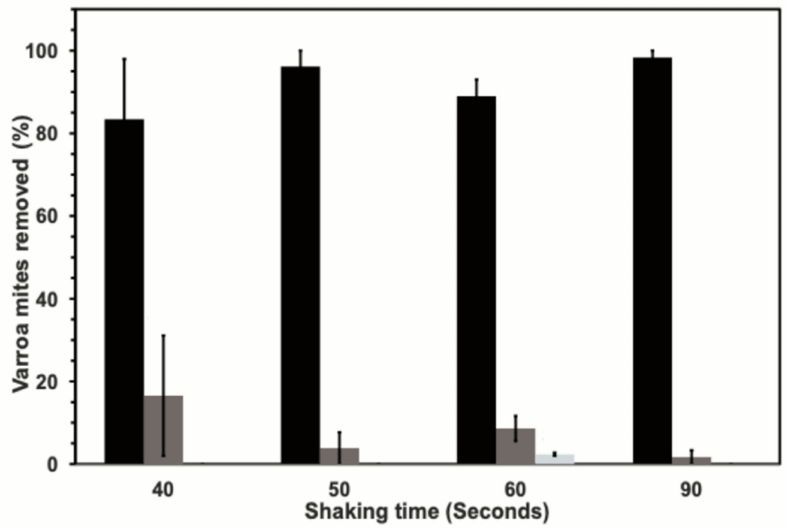
Figure 3. The percentage (mean ± standard err (se)) of Varroa dislodged from collected honey bees by using four different shaking periods. The percentage of mites recovered from the first and second shaking periods are given by black and dark-gray bars, respectively. The percentage of residual mites collected from final visual inspection of bees is also given where observed (light-gray